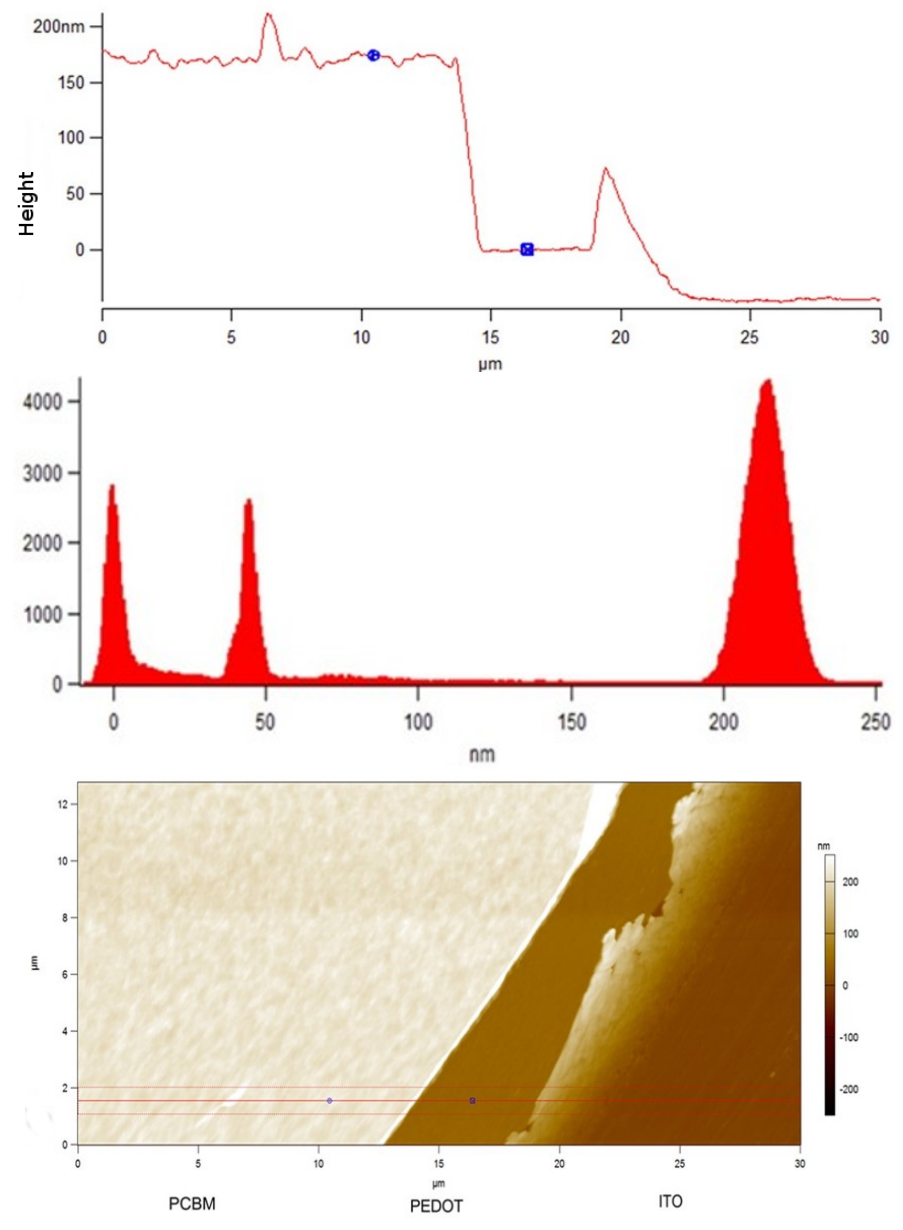
Figure 8. Extraction profiles of PCBM, PEDOT, and ITO. Top to bottom: the profile collected by Z sensor channel; a histogram of the height difference between PCBM:PEDOT and ITO; 2D topographical